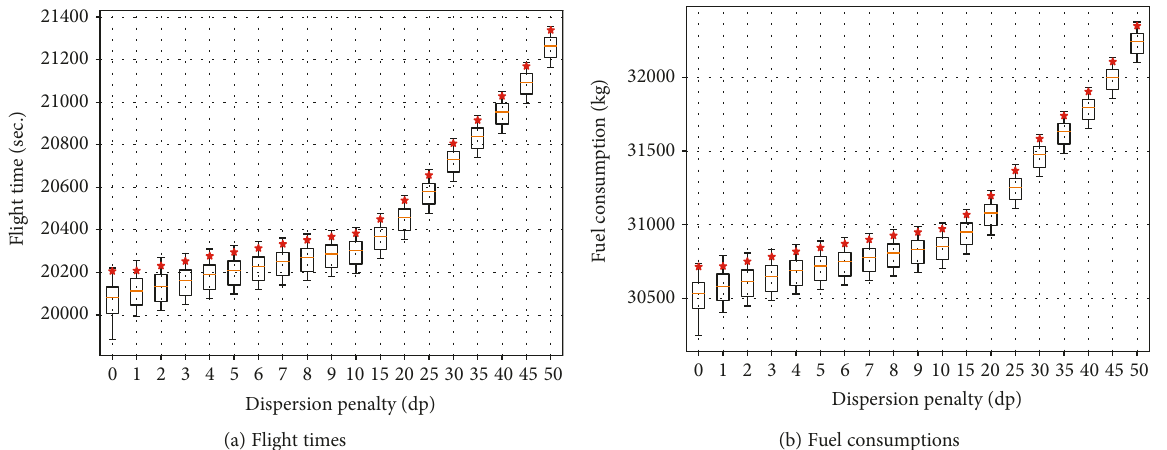
Figure 7: 2016-Oct-05 results: boxplots denote predicted uncertainties (based on EPS data and computed using the robust fl ight planning algorithm); red stars denote realized values (based on reanalysis data).